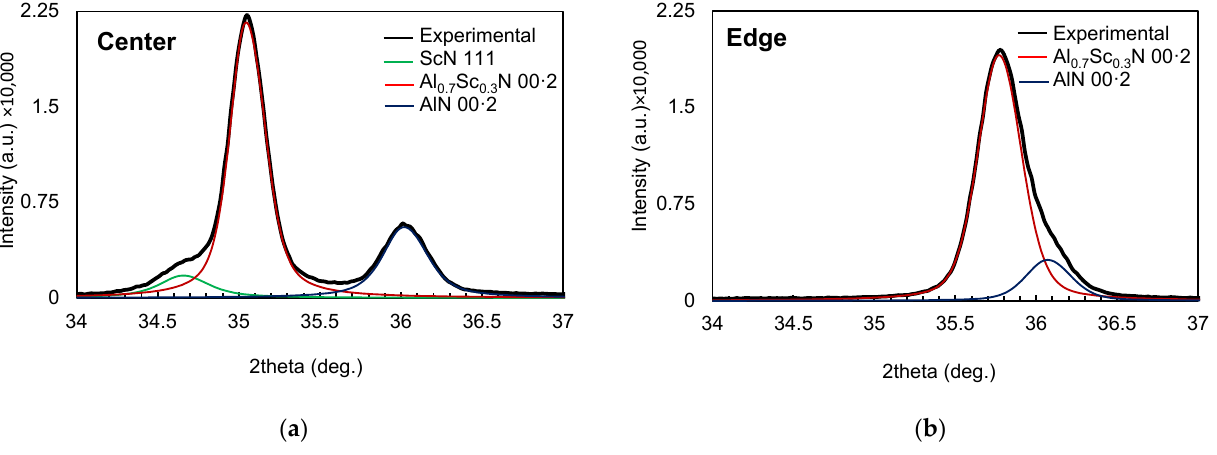
Figure 9. ( a ) Deconvoluted XRD pattern for a sample located at the center and ( b ) at the edge of the wafer.